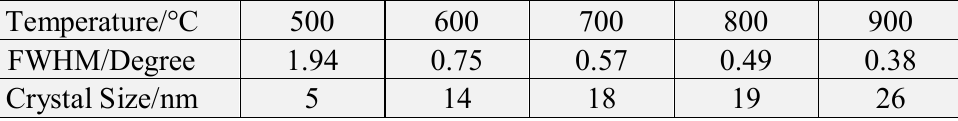
Table 1. Crystallite size as function of annealing